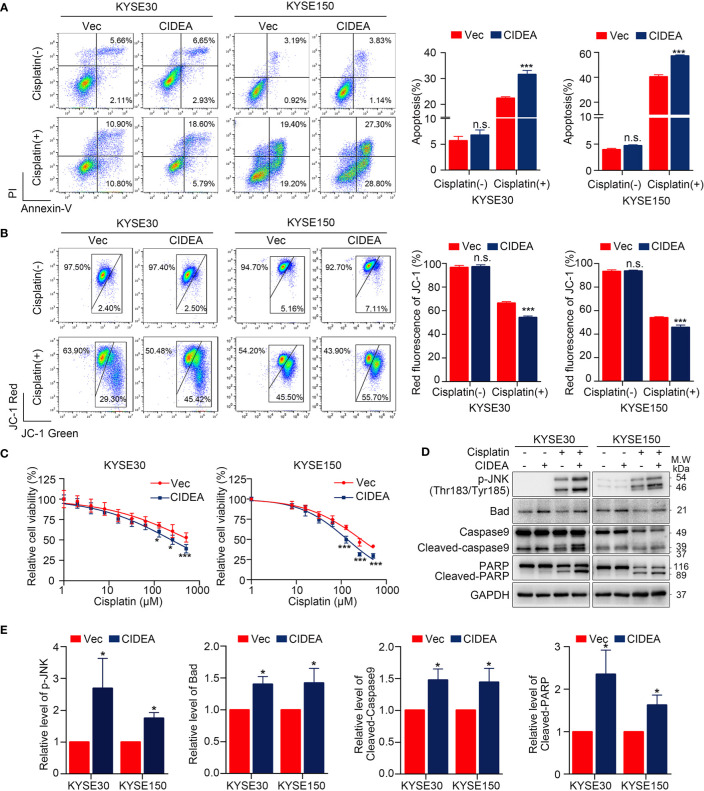
Overexpression of CIDEA promoted apoptosis in ESCC cells. (A) Cisplatin treated cells were stained for Annexin V/PI and analyzed FACS. The percentage of Annexin V+ cells is shown. (B) Mitochondrial potential was measured by flow cytometry using the JC-1 molecular probe in ESCC cells with or without cisplatin treatment. Enhanced green fluorescence ratio of cells indicated a decrease in mitochondrial potential. (C) Cell viability of CIDEA overexpressing cells and control cells treated with different concentrations of cisplatin. (D) Caspase-9, PARP, and p-JNK were detected in CIDEA overexpressing cells and control cells with or without cisplatin treatment. (E) Quantification of p-JNK, Bad, cleaved-Caspase9, and cleaved-PARP in KYSE30 and KYSE150 cells treated with cisplatin. Statistical data are represented as mean ± SD. *P < 0.05; **P < 0.01; ***P < 0.001; n.s., P > 0.05.